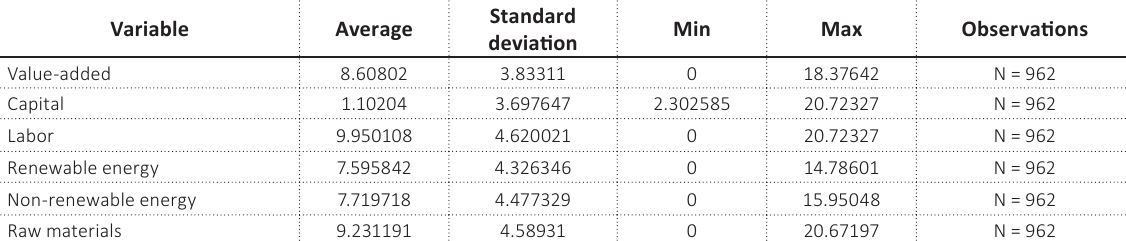
Table 1. Descriptive statistics of explanatory variables of the productivity growth of manufacturing firms in